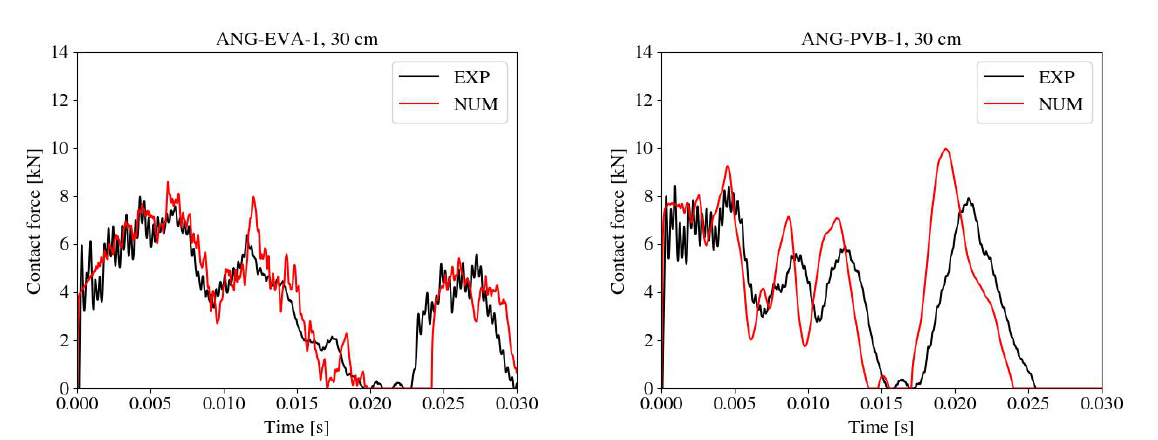
Fig. 12 Validation of contact forces from numerical analysis (NUM) against experimental data for contact force (EXP) derived from the accelerations of the impactor for laminated glass samples for the impact height of 30 cm. The contact forces were derived from the accelerations of the impactor during the contact. The filter CFC 1000 was again applied to the data to reduce the noise, e.g., (Alter et al. 2017). The validation against experimental data in